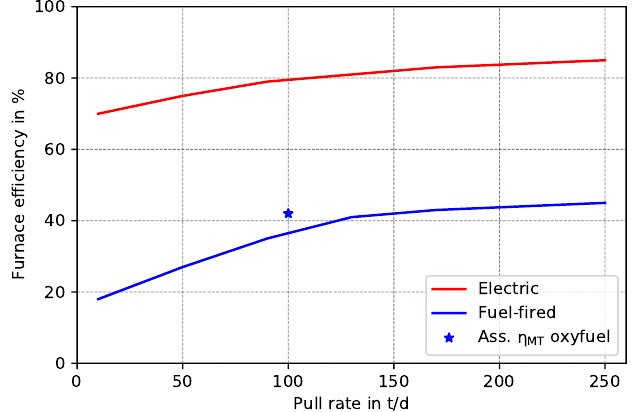
Figure 2. Efficiencies of fuel-fired and electric furnaces as a function of pull rate, adapted from Ref. [10]. In this work, a melting tank efficiency η MT of 42% is assumed for a 100 t/d oxyfuel melting system (see Section 4.4.1).